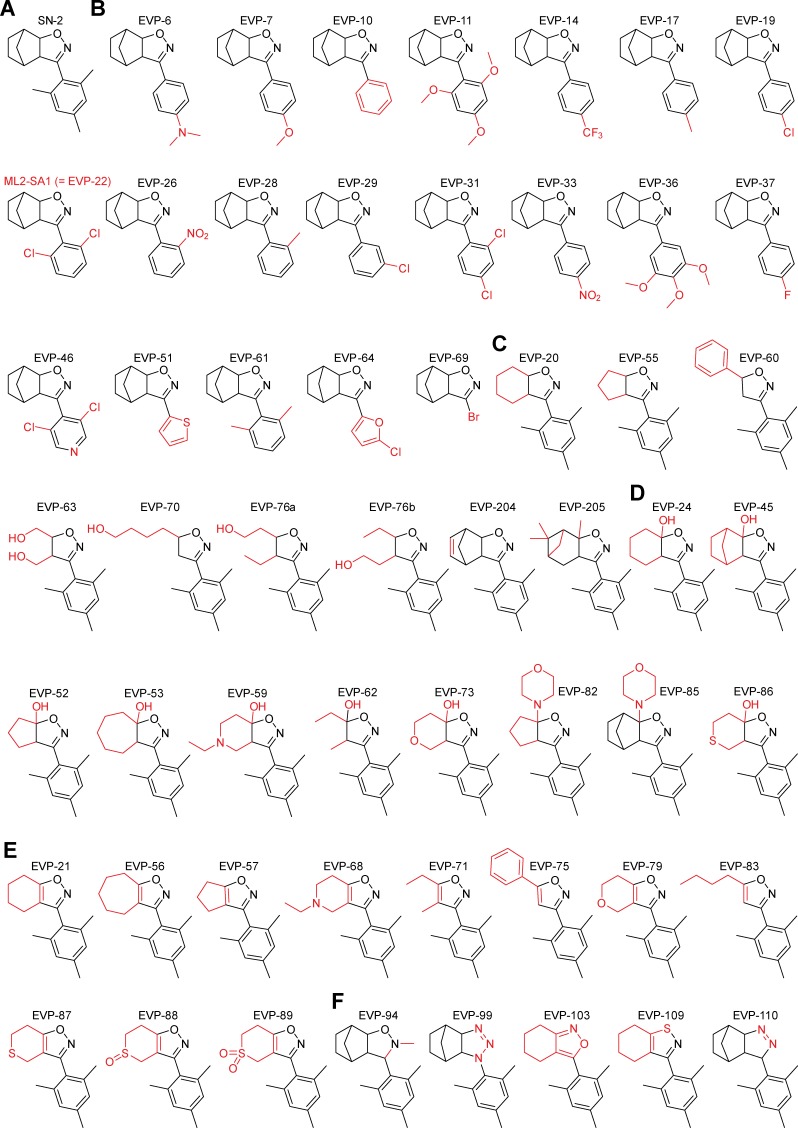
Structures of SN-2 analogues.Shown are the chemical structures of all generated SN-2 analogous compounds. Changes in comparison to SN-2 are highlighted in red. (A) Structure of the lead compound SN-2. (B) Variations in the aryl ring. (C) Isoxazolines with variations in the aliphatic residue. (D) Different 5-hydroxy- and 5-morpholino-isoxazolines. (E) Different isoxazoles. (F) Variations in the heterocycle. With synthesis strategy a we performed numerous variations of the residues on SN-2. Starting with suitable aromatic aldehydes (such as variably substituted mono- and poly-methoxybenzaldehydes, chloro- and fluorobenzaldehydes, trifluoromethyl- and nitrobenzaldehydes, thiophene- and furan-carbaldehydes), the appropriate oximes were prepared. Subsequent conversion into nitrile oxides with PIFA (= [bis (trifluoroacetoxy)iodo]benzene) and reaction with norbornene and other cyclic and acyclic olefins in a Huisgen [3 + 2] cycloaddition led to analogues of SN-2 with a broad range of variations in the aromatic ring and the ring/substituents attached to the isoxazoline ring. Synthesis strategy b (Figure 1A) resulted in fully aromatic isoxazole analogues of SN-2, bearing annulated ring systems or open chain substituents (R4, R5). Starting from enolates of appropriate cyclic or acyclic ketones, substituted 5-hydroxyisoxazolines were generated via a Huisgen cycloaddition with mesitonitrile oxide. Dehydration with sodium carbonate resulted in aromatic analogues of SN-2. 5-Morpholinoisoxazolines (EVP-82, EVP-85) were generated in a similar manner from the ketones via enamines (Fos et al., 1992; Kuehne et al., 1964). Other 5-membered ring heterocycles like isoxazolidines (EVP-94) (Cerri et al., 1974), isomeric isoxazoles (EVP-103) (Fos et al., 1992), triazolines (EVP-199), pyrazolines (EVP-110) (Wulfman et al., 1988), and isothiazoles (EVP-109) (Akiba et al., 1985) were obtained by following established procedures of heterocyclic chemistry.